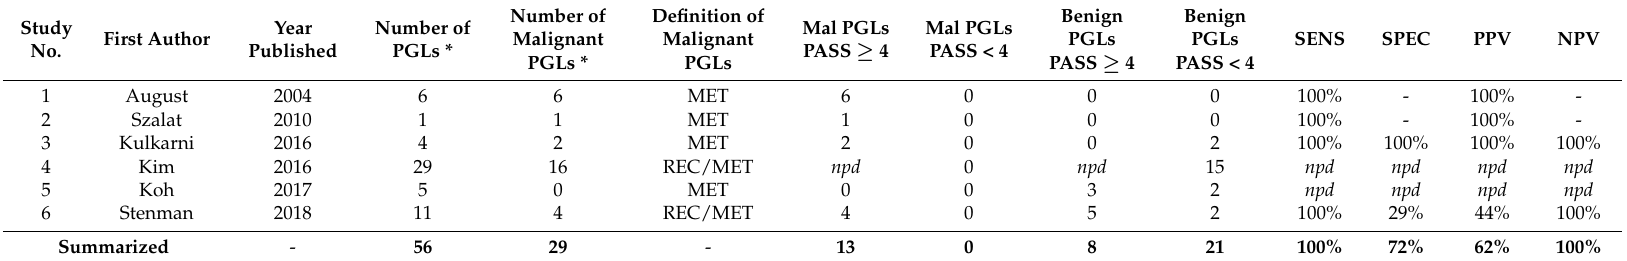
Table 2. PGL cohorts stratified by the PASS algorithm.